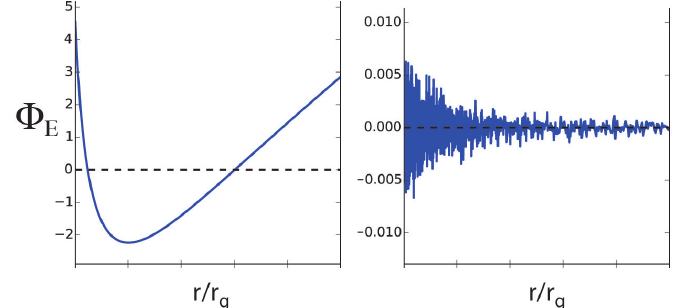
Figure 9. Evolution of the gap electric field in a magnetosphere of a supermassive black hole with the same parameters as in Figure 8. The left panel shows the electric flux Φ E = t = 0. The right panel shows the electric flux at time t = 20 r g / c , roughly the onset of the quasi-steady oscillations. Note the change of scale on the vertical axis between the two panels. The amplitude of E (cid:48) r during the quasi-steady oscillations is about 10 − 3 of its initial magnitude at the null surface. The fiducial opacity in this case is τ 0 =